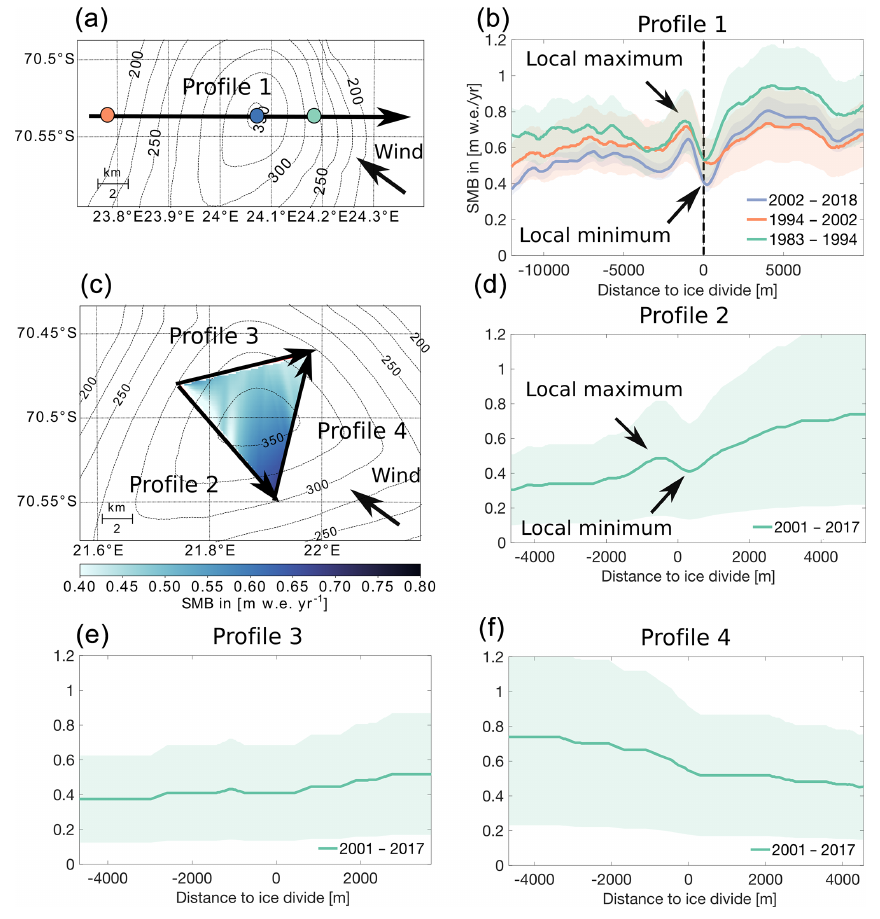
Figure 3. Topography of the LIR, the location of the two AWSs (green and orange dots), the drilling site of the FK17 ice core (blue dot) and the GPR tracks recorded during the 2017 Mass2Ant field campaign (a) . Also shown is the SMB reconstructed from the GPR profile on the LIR (b) as well as the topography and the GPR tracks on the HIR (c) , where three SMB profiles were reconstructed from GPR profiles for a single time window (2001–2007) by tracking a single IRH of age deduced from the depth–age relationship at the LIR ice core (d, e, f) . The topography of the ice rises shown in (a) and (c) is based on the 90m TanDEM-X digital elevation model (© DLR